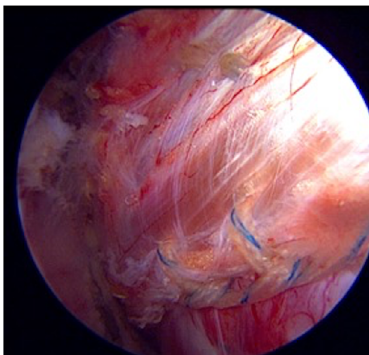
Figure 5. Arthroscopic view of transferred latissimus dorsi tendon. Right shoulder, view from lateral portal.